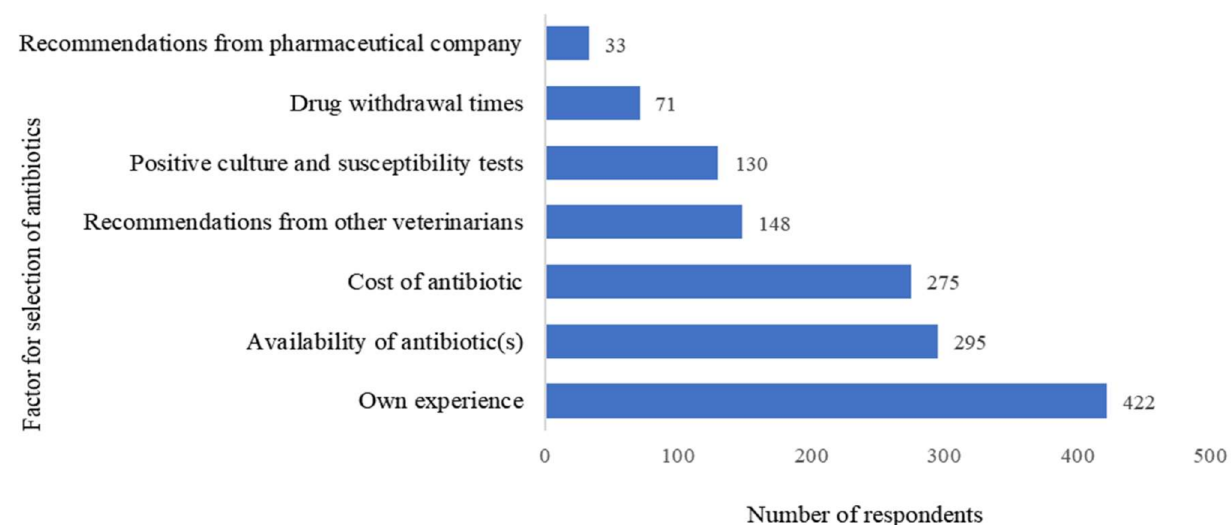
Figure 2. Factors determining the choice of antimicrobial use by veterinarians * (* Question: What are the top three factors in determining the choice of antibiotics use in your treatment? Choose among the following (Own experience/Availability of antibiotic(s)/Recommendations from other veterinarians/Cost of antibiotic/Positive culture and susceptibility tests/Drug withdrawal times/Recommendations from pharmaceutical company). Each veterinarian was asked to choose up to three top factors determining the choice of